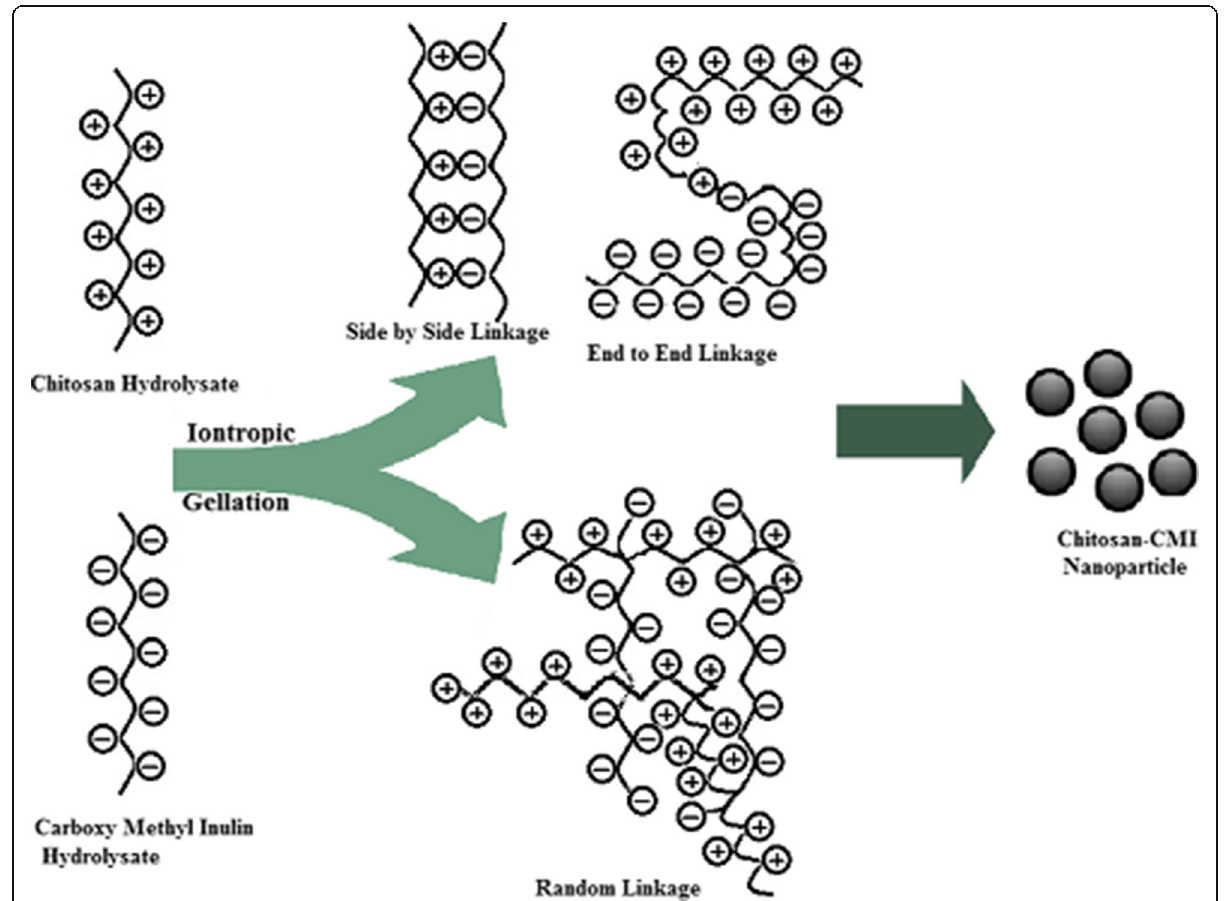
Fig. 1 Schematic presentation of chitosan-CMI nanoparticles